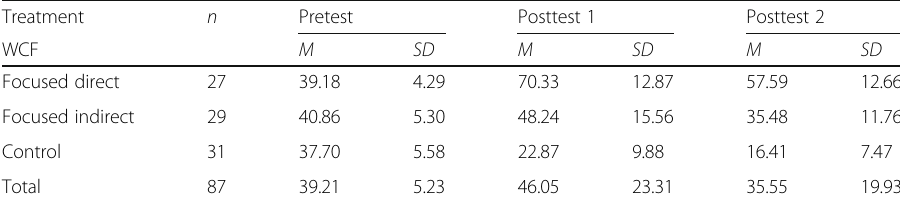
Table 6 Descriptive statistics for the narrative writing task and text summary Treatment